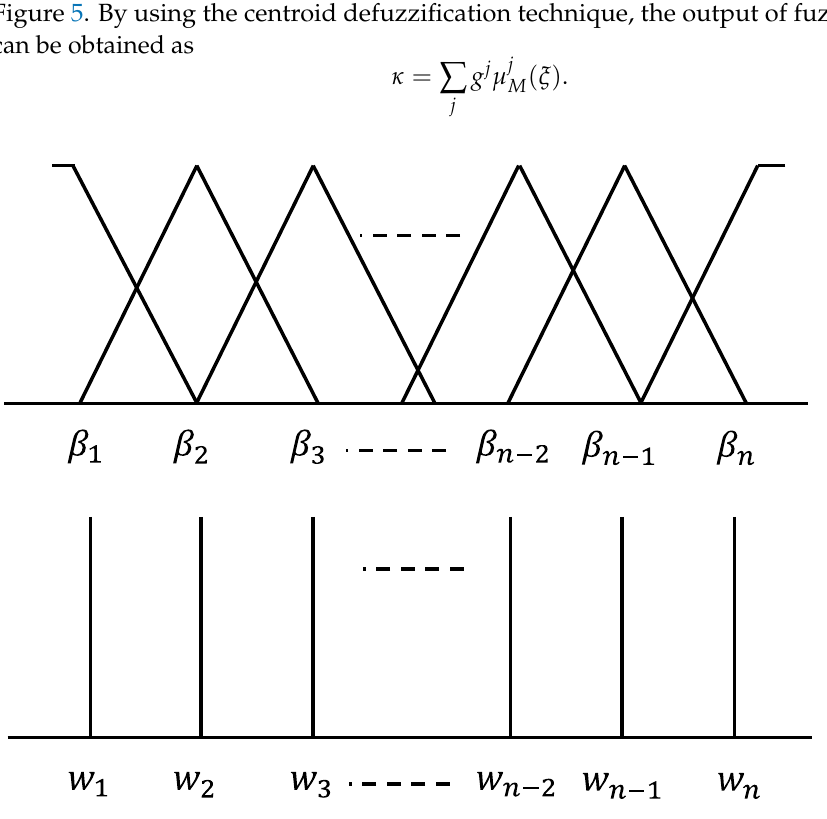
Figure 5. The membership function of fuzzy system.